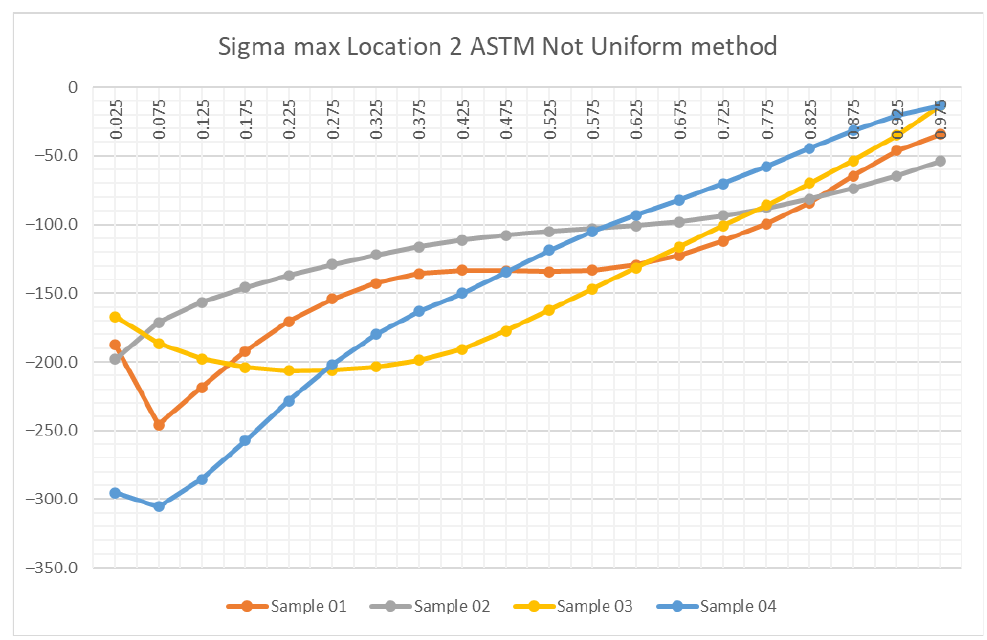
Figure 7. The resulting values of residual stresses (Sigma max) for all four samples at the measuring Location 2.